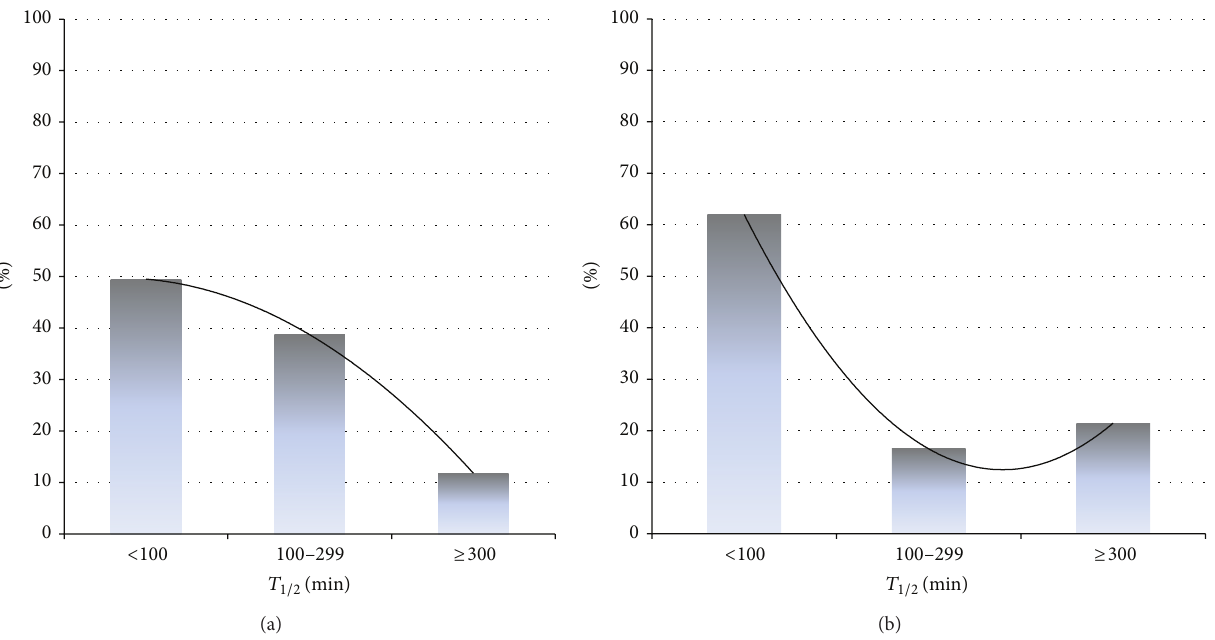
Figure 2: Gastric emptying in idiopathic and diabetic subjects. (a) Percentage of previously healthy (idiopathic) subjects. (b) Percentage of diabetic subjects with normal ( < 100mins), mildly delayed (100–299 mins), and grossly delayed gastric emptying ( ≥